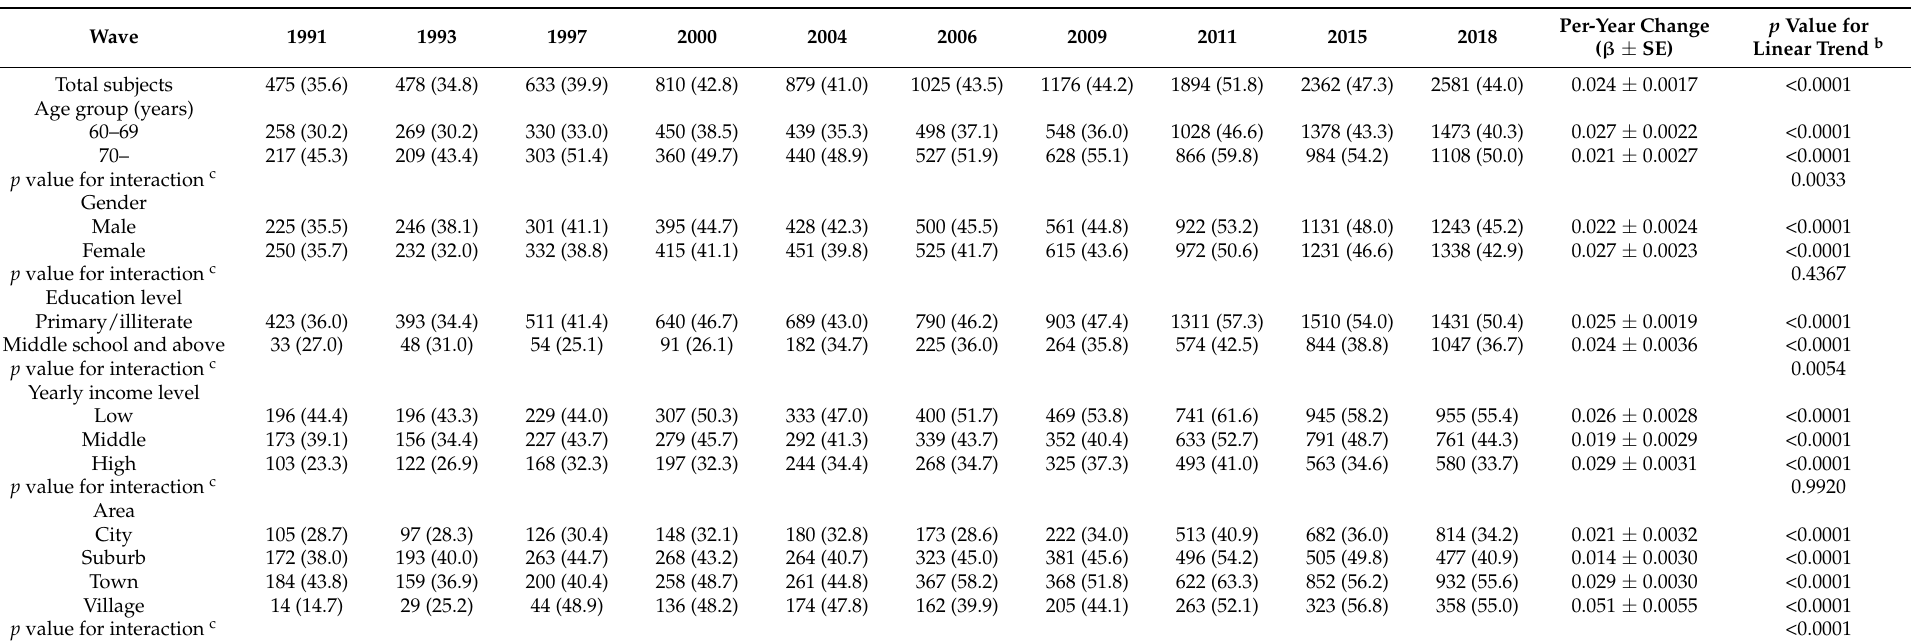
Table 3. Trends in proportion of daily protein intake below EAR among the elderly Chinese, 1991 to 2018 a